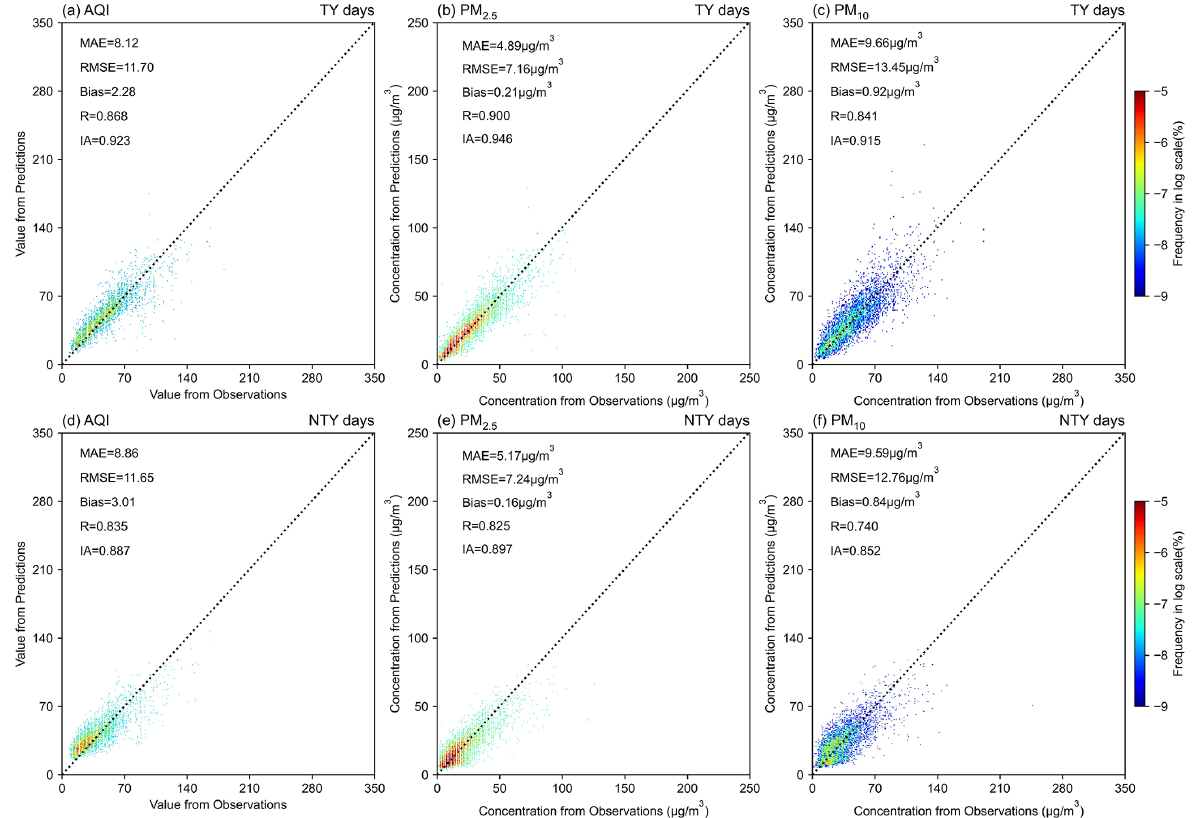
Figure 4. The results of AQI, PM 2 . 5 and PM 10 of three testing stations predicted by the RF model: (a) AQI of TY days; (b) PM 2 . 5 of TY days; (c) PM 10 of TY days; (d) AQI of NTY days; (e) PM 2 . 5 of NTY days; (f) PM 10 of NTY days.